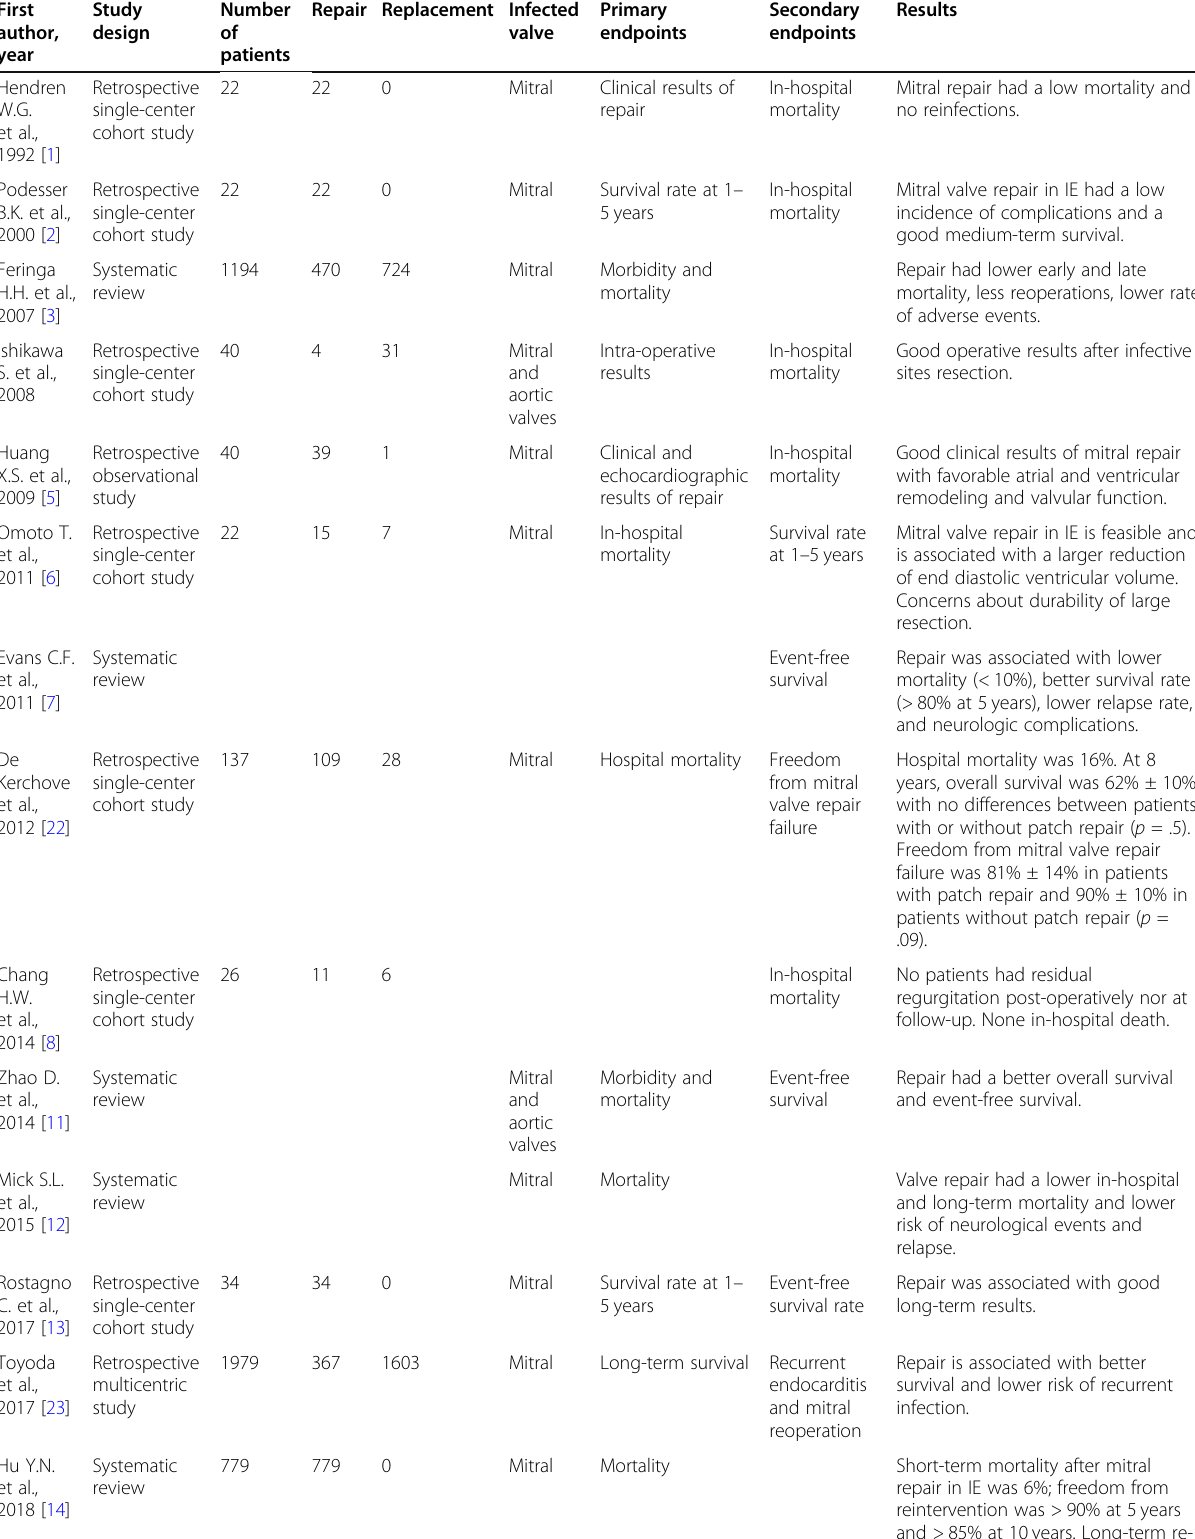
Table 4 Review of the literature concerning mitral valve repair in